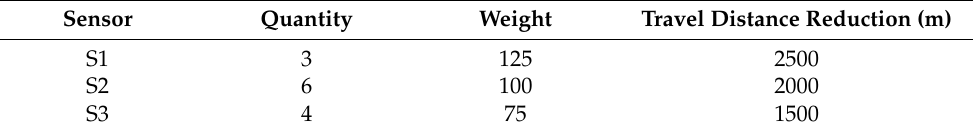
Table 2. Sensors attributes.